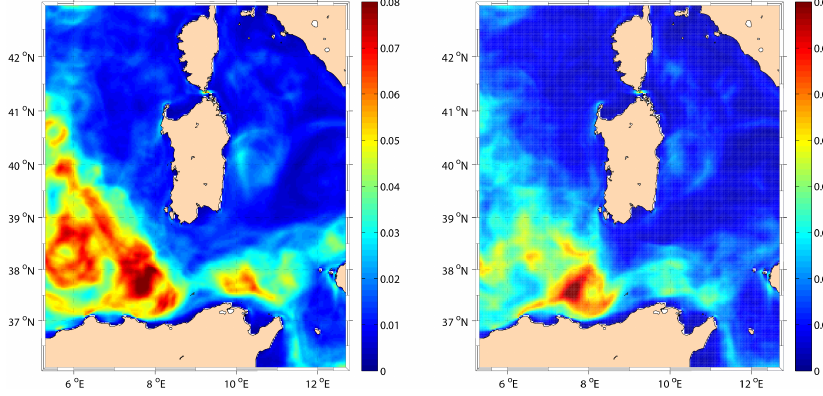
Figure 8. Eddie kinetic energy for BF (left) and BFC experiments. Units are m 2 s − 2